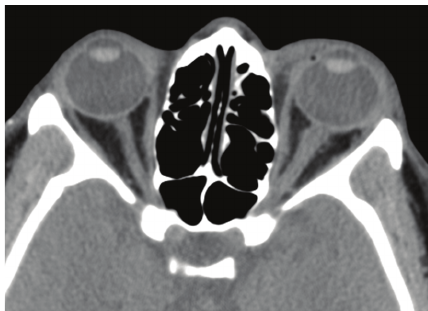
Figure 1: CT orbits demonstrating irregularity to left optic nerve and adjacent fat stranding. Unenhanced CT orbit study demon- strates shaggy irregularity of the distal left optic nerve, which is enlarged compared to the right. Surrounding mild fat stranding is also evident. Minor preseptal soft tissue swelling is apparent with tracking of a thin hematoma along the lateral left orbital wall. The globes are intact, and no additional traumatic injury is